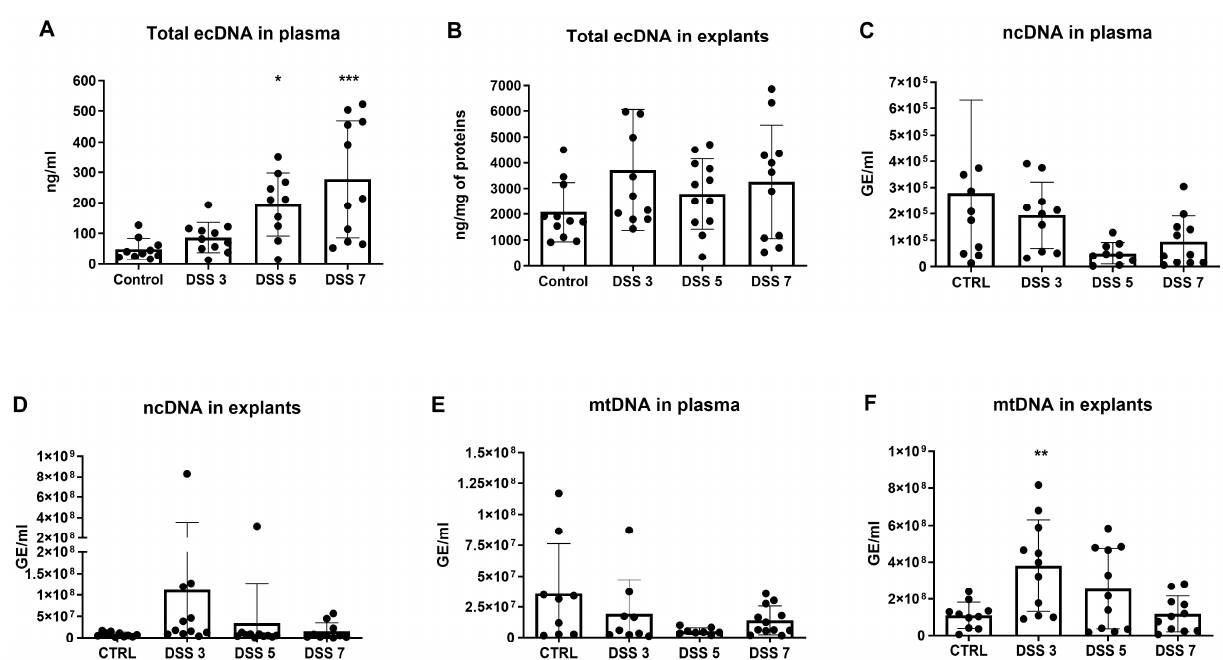
Figure 1. Total, nuclear and mitochondrial DNA in plasma and colon explants. ( A ) the concentration of total ecDNA in plasma showed a time-dependent trend and was highest in DSS 7 group. ( B ) total extracellular DNA (ecDNA) in explants rose on day 3, however was lower in other timepoints. ( C ) the concentration of nuclear (ncDNA) in plasma did not differ between the groups. ( D ) ncDNA in explants reached the highest amount on day 3 and subsequently decreased until the end of the experiment. ( E ) mitochondrial (mtDNA) in plasma did not differ between the groups. ( F ) mtDNA in explants showed a similar pattern compared to ncDNA in explants, where mtDNA concentration rose on day 3 and decreased in other timepoints. * = p < 0.05; ** = 0.05 > p > 0.01; *** = p < 0.001 .